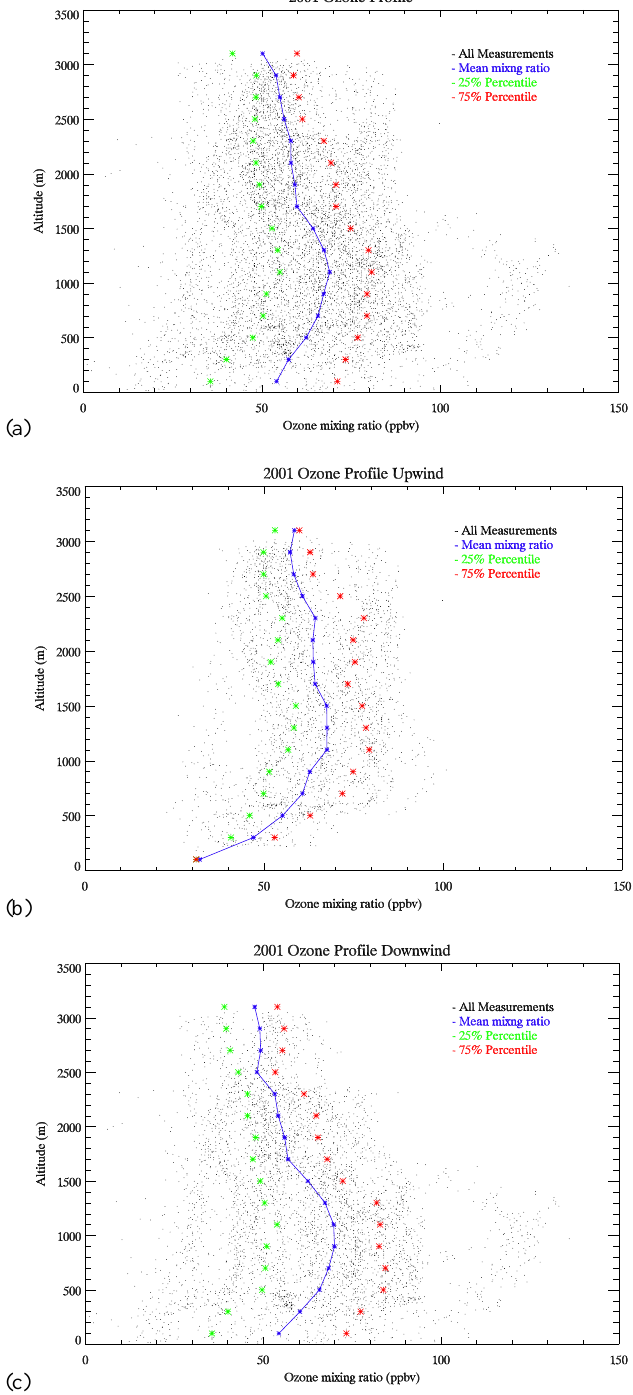
Fig. 7. Vertical distributions of tropospheric ozone over the Balti- more/Washington region in 2001: (a) all spirals; (b) upwind spi- rals; (c) downwind spirals. Measurements are grouped every 200m according to the altitude; the 25th percentile, mean, and 75th per- centile are shown for each